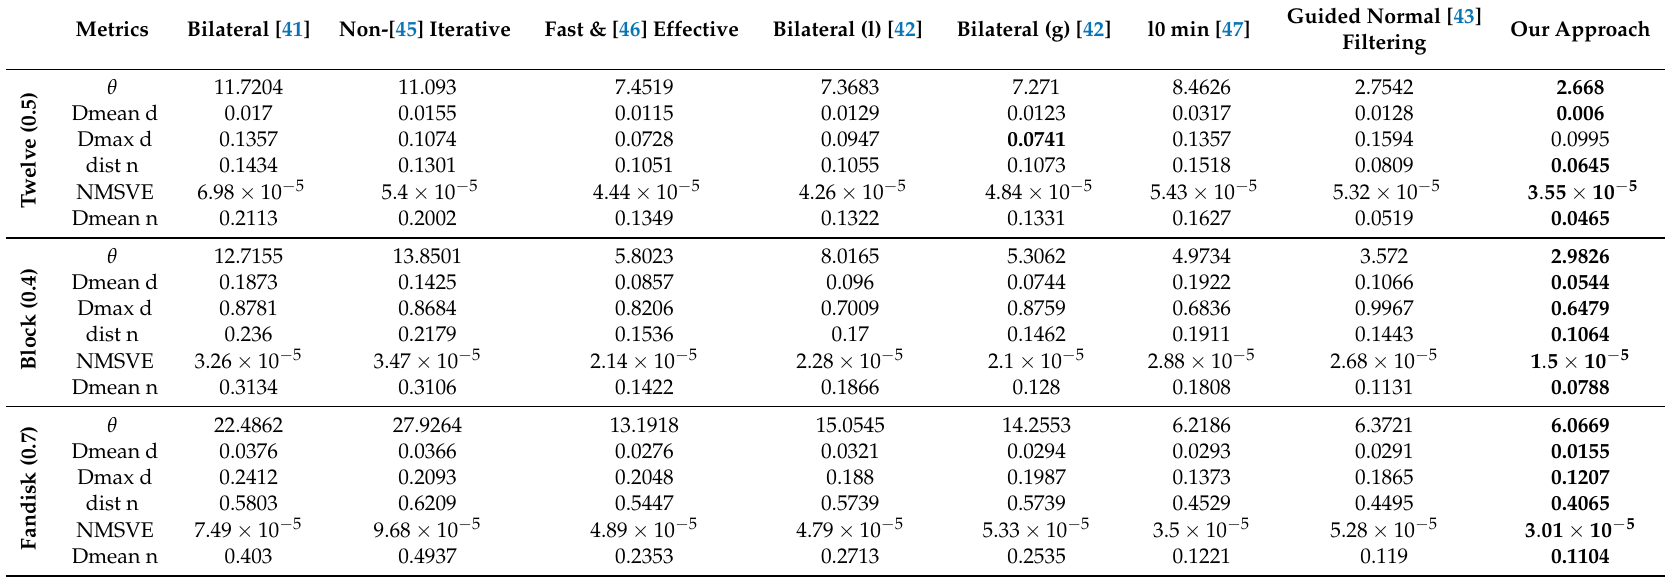
Table 6. Evaluation of the experimental results using different metrics. The lowest value per each row is highlighted in